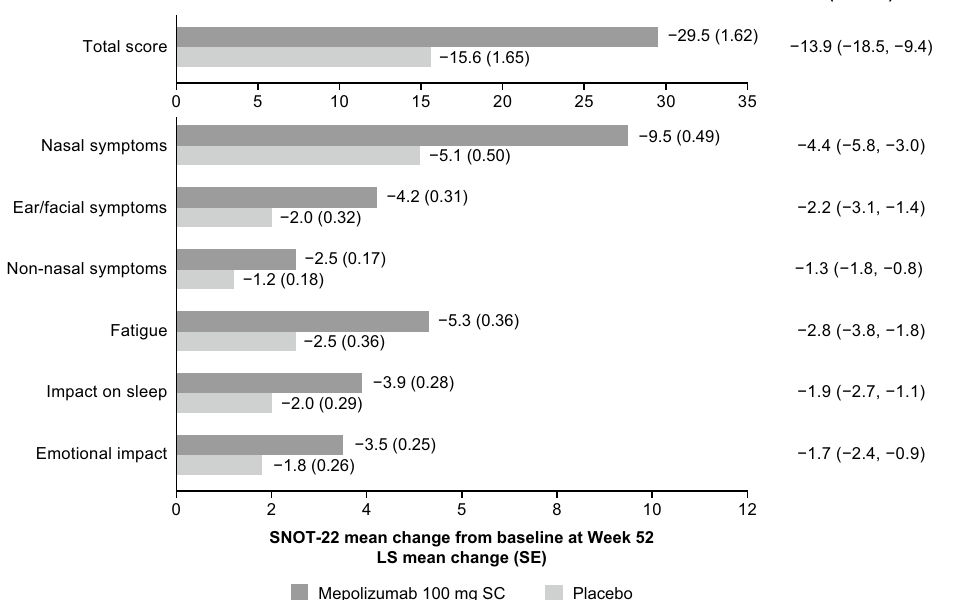
Fig. 8 Change from baseline in SNOT-22 total and domain scores at Week 52. Estimates are based on weighting applied to each level of class variable determined from observed proportions. CI confidence interval, LS Least squares, SC Subcutaneous, SE Standard error, SNOT-22 Sino-nasal outcome